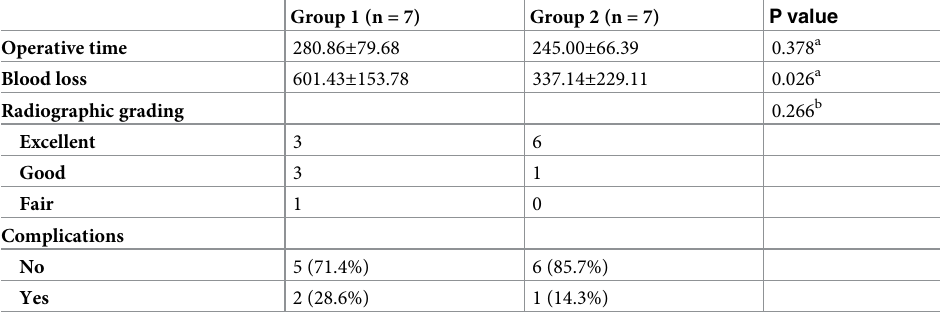
Table 3. Clinical